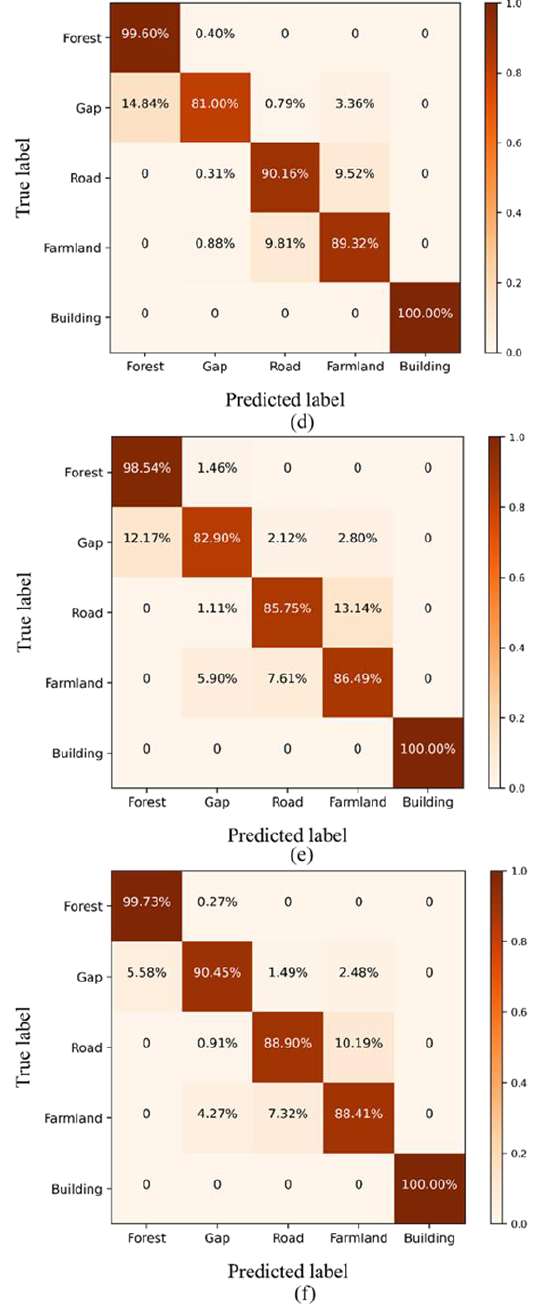
Figure 7. Normalized confusion matrices of geo-object classification in study area II using KNN ( a , b ), SVM ( c , d ), and RF ( e , f ), in which ( a , c , e ) used edge information. In contrast, ( b , d , f ) did not use edge information.